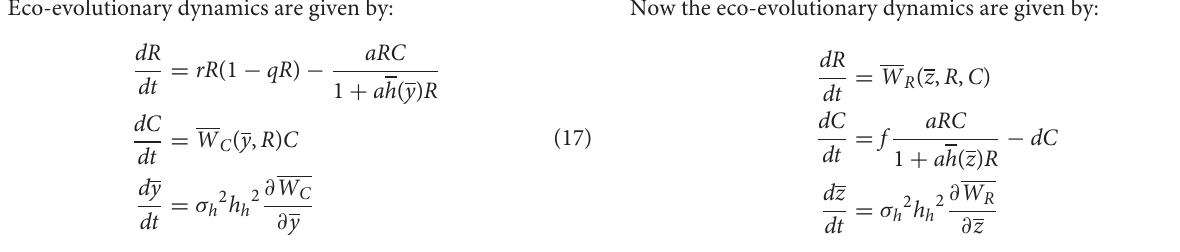
ητ h h ( θ h ) h ( θ h )) exceeds the expected minimum ( η ) because of the ). Note that the evolved minimum ( √ τ h 2 = 2 − σ h b b ητ h h ( θ h ) 1.0; ; dashed orange line), the quantitative trait mean ( y , red line), and its expected optimum ( θ h = = τ h 2 − σ h 2 q h ( θ h )) regardless of selection strength even when the attack rate is high, b b h ( θ h )] (M,N) . Other parameter values are: r 5.0, q 0.04, e 0.2, d 0.1, σ h = = = = = b